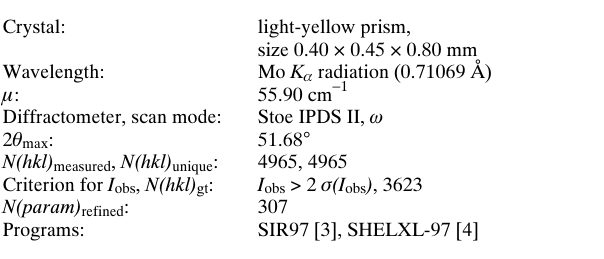
Table 1. Data collection and handling.